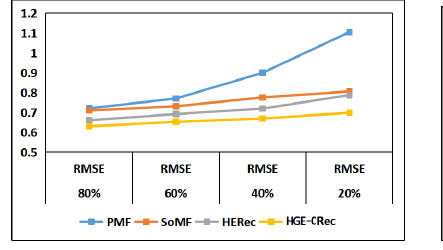
( a ) Comparison of RMSE with the change in the training rate on dataset Scholat